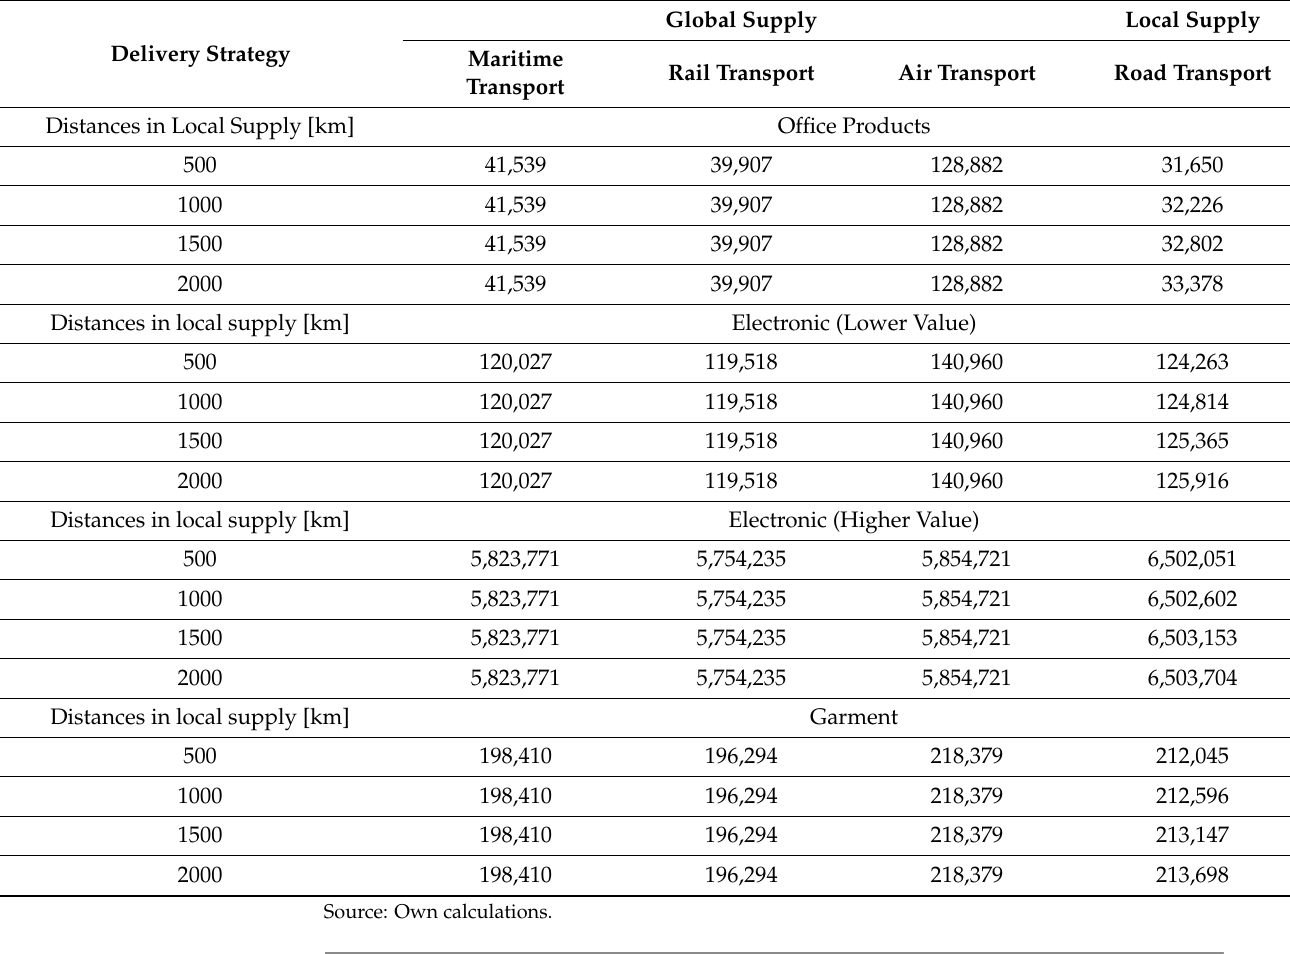
Table 3. Results of the simulations—impact of the increase of freight rates on total costs of deliveries and production [USD/year].